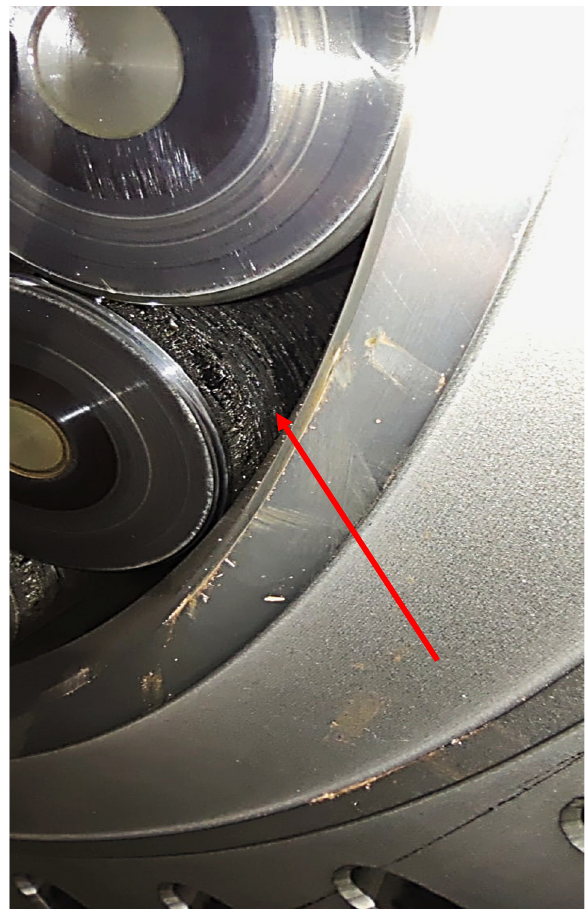
Figure 12. Bearing elements with visible heat-adhesion damage (arrow).